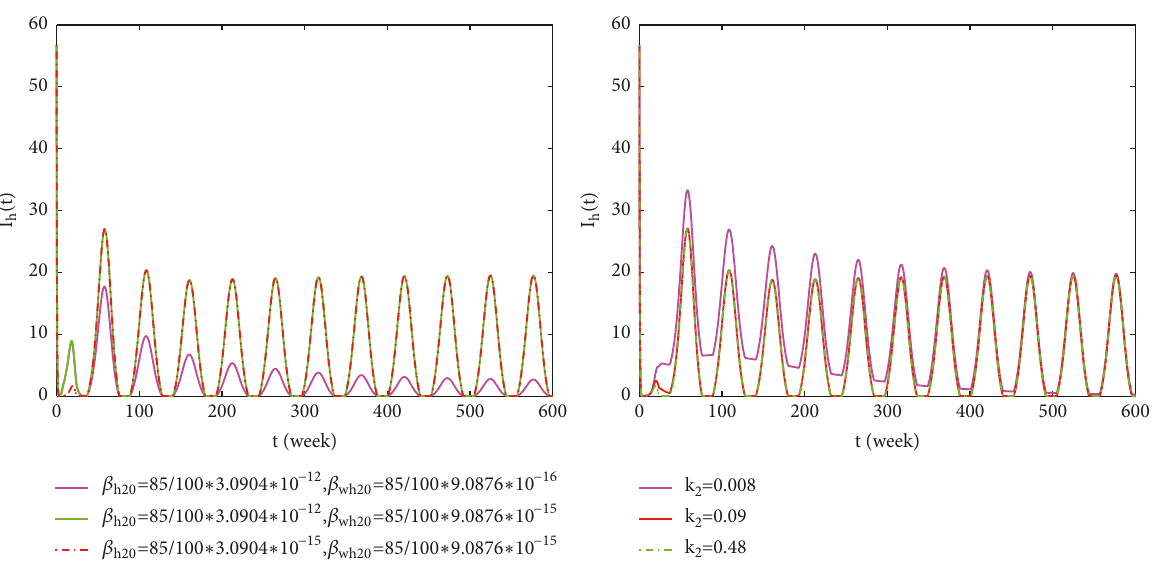
Figure 5: The curve-trend diagram of 𝐼 ℎ with time, when 𝛽 ℎ1 or 𝛽 𝑤ℎ1 takes different values.